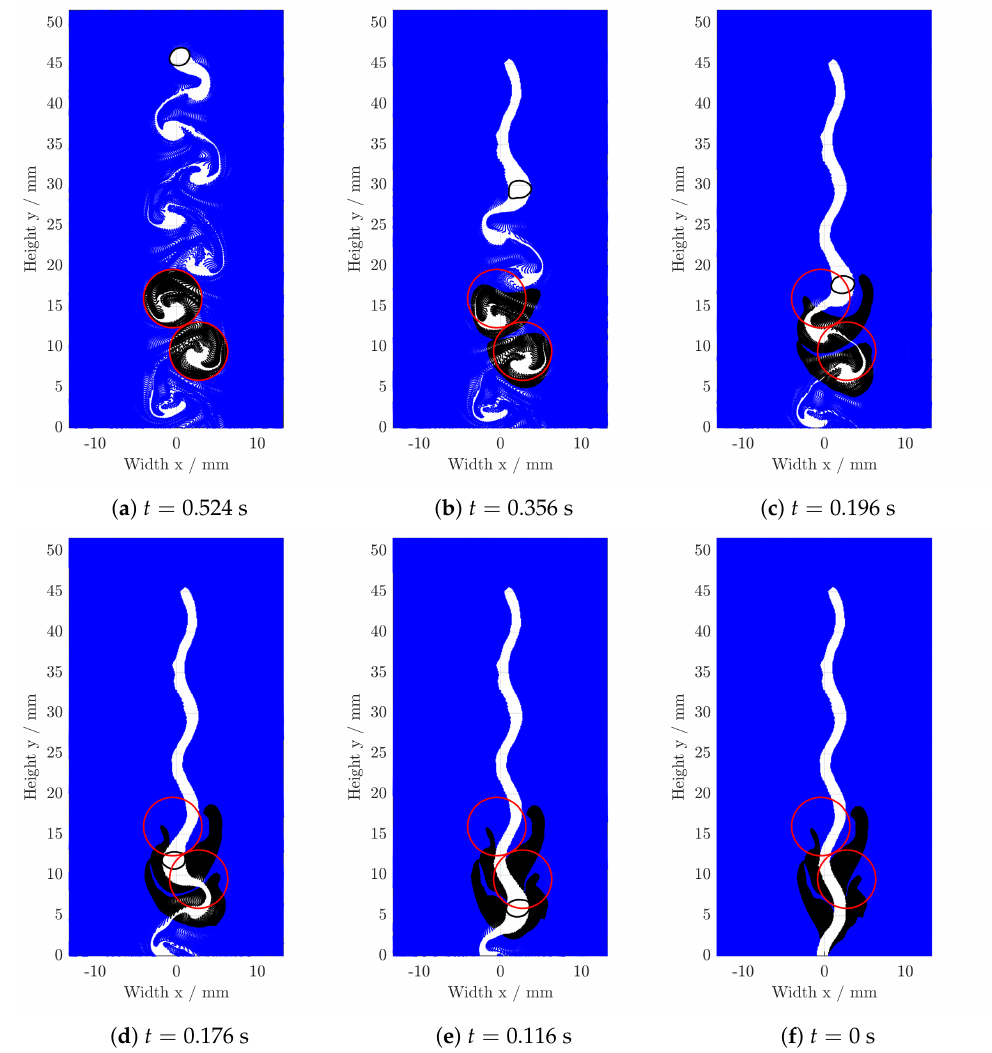
Figure 7. Backwards tracking of fluid parcels transported into two single vortices from their final positions in ( a ) to their initial positions in ( f ). Red circles approximate the vortices. Fluid parcels in the approximated vortices (black) are tracked to their initial positions, blue denotes the rest of the liquid phase. The white area displays fluid parcels excluded due to nonphysical